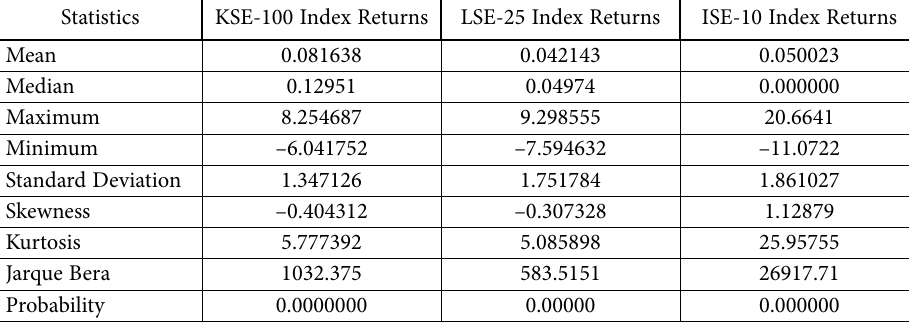
Table 1. Summarization of descriptive statistics (source: authors’ estimation)